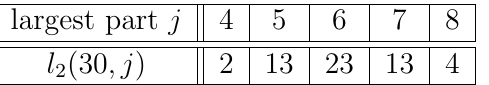
(30 , j )) biconnected graph- 2